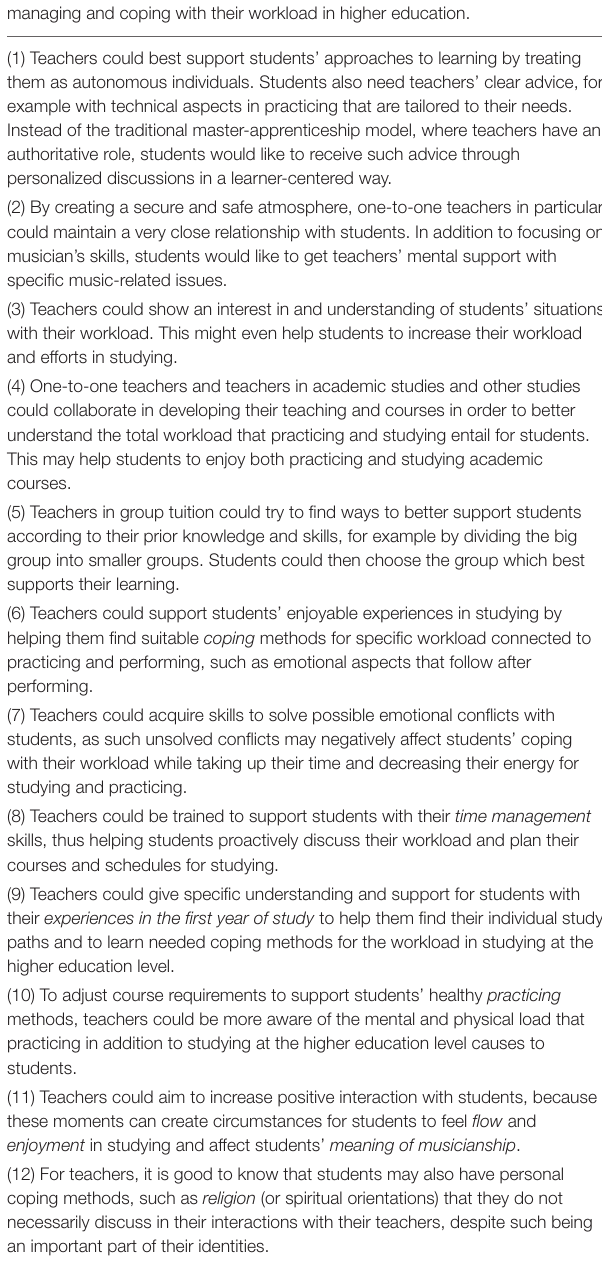
TABLE 4 | A music student’s individual workload and tools for